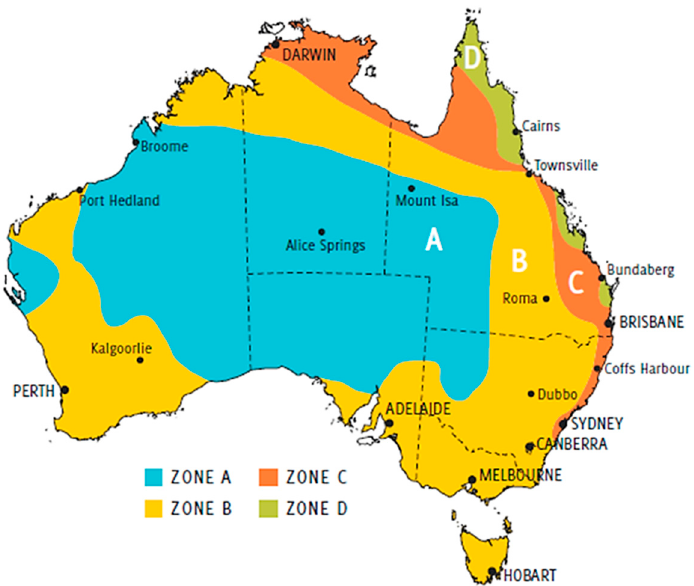
Figure 1. In-ground decay hazard map of the continent of Australia delineating relative vulnerability to attack by decay fungi (Zone D has the greatest in-ground decay hazard). Image used with permission from [22].